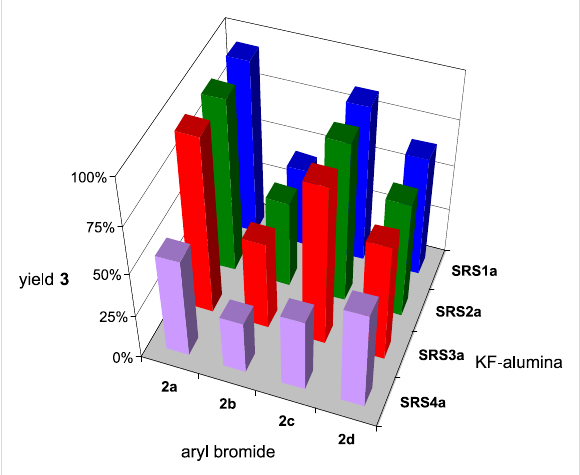
Figure 4: Results of the Suzuki–Miyaura reaction according to Scheme 1 assisted by KF-loaded aluminas [5 g SRS1a – 4a , 32 wt % KF: cf. Table 2; ball milling: 2 agate milling beakers ( V = 45 ml), 6 agate milling balls ( d = 15 mm) per beaker, 800 rpm, 10 min; batch: